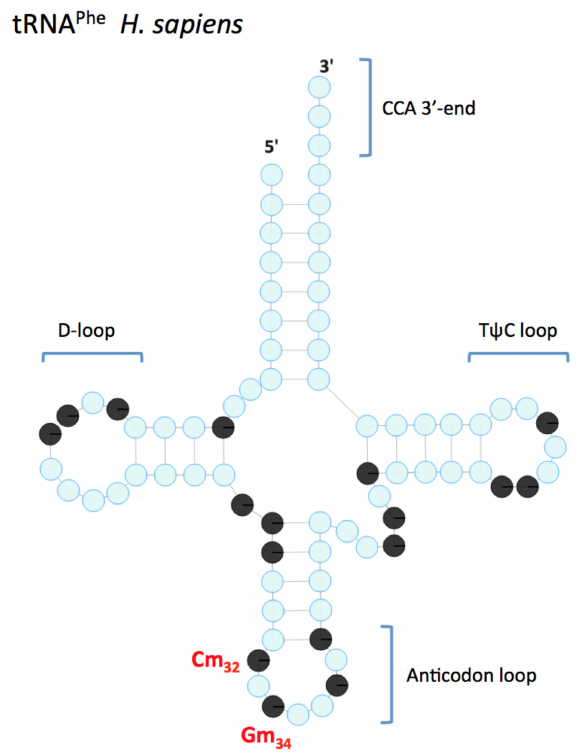
Figure 2. Representation of the mature human tRNA Phe (76 nucleotides). The two Nm modifications in the anticodon loop, in C 32 and G 34 , are placed by the 2 (cid:48) -O-methyltransferase FTSJ1 and are annotated in red. Blue circles are for non-modified nucleotides, black circles mean modified nucleotides (adapted from